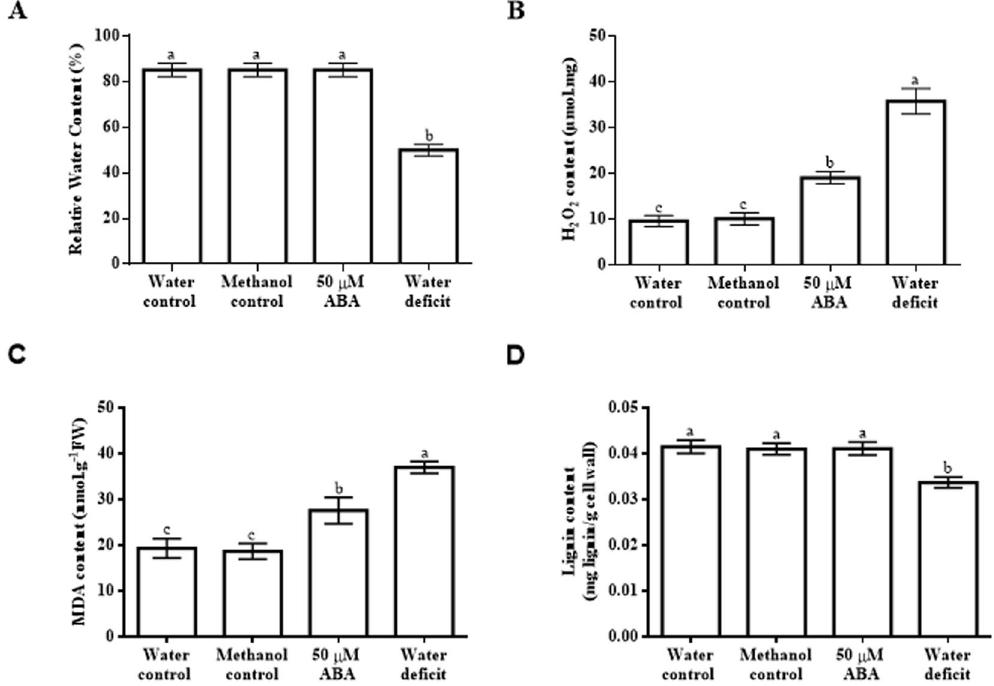
Figure 2. Effect of exogenous abscisic acid and water deficit on relative water content, H 2 O 2 content, lipid peroxidation and lignin content in maize leaves. ( A ) Relative water content of maize leaves in response to ABA or water deficit. ( B ) Levels of H 2 O 2 in maize leaves upon application of ABA or exposure to water deficit. ( C ) Changes in lipid peroxidation based on measuring MDA content in leaves. ( D ) Cell wall lignin content of maize leaves subjected to ABA treatment or water deficit. Data represent means of three independent experiments. The error bars signify standard errors, where bars with the same letters are statistically similar at p <